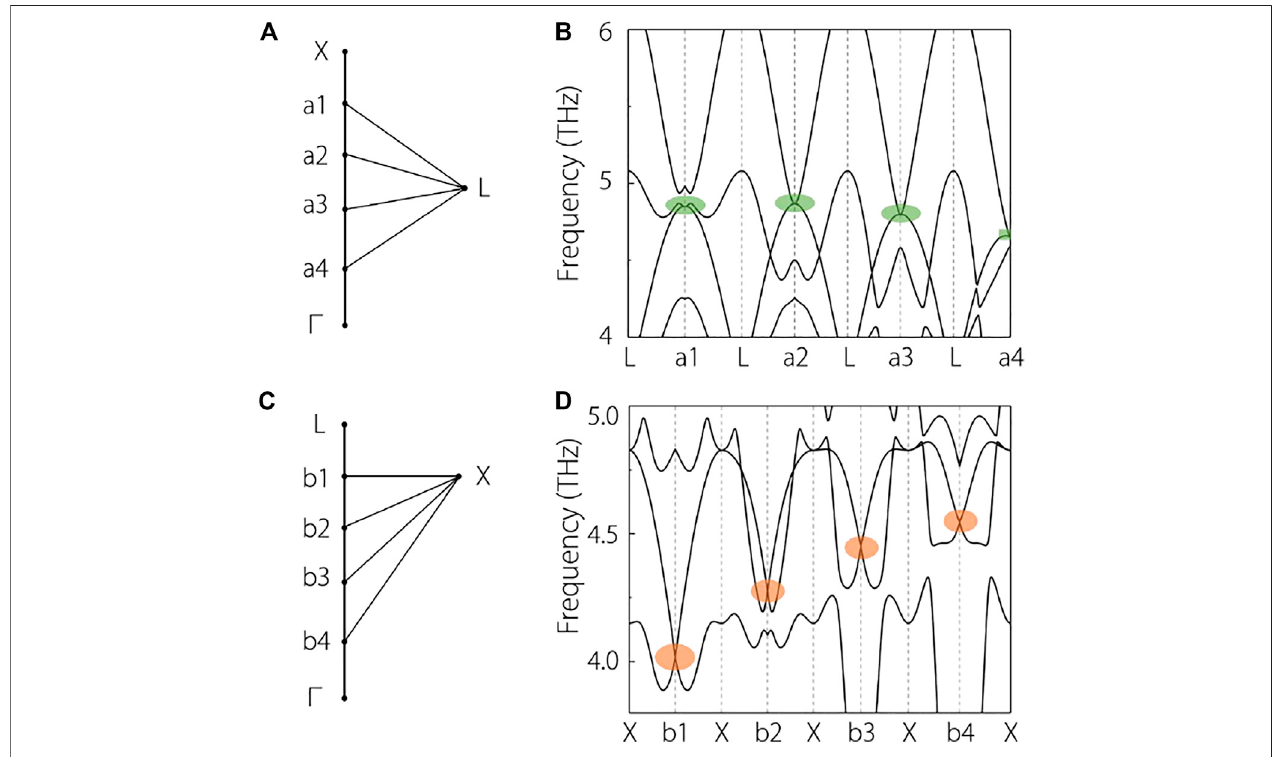
FIGURE 4 | (A) , (C) some selected symmetry points along the X- Γ and the L- Γ , respectively. (B) and (D) calculated phonon dispersions along the L-an and X-bn ( n (cid:1) 1 – 4). The linear two-degenerate points and the quadratic two-degenerate points are highlighted with orange and green circles, respectively.